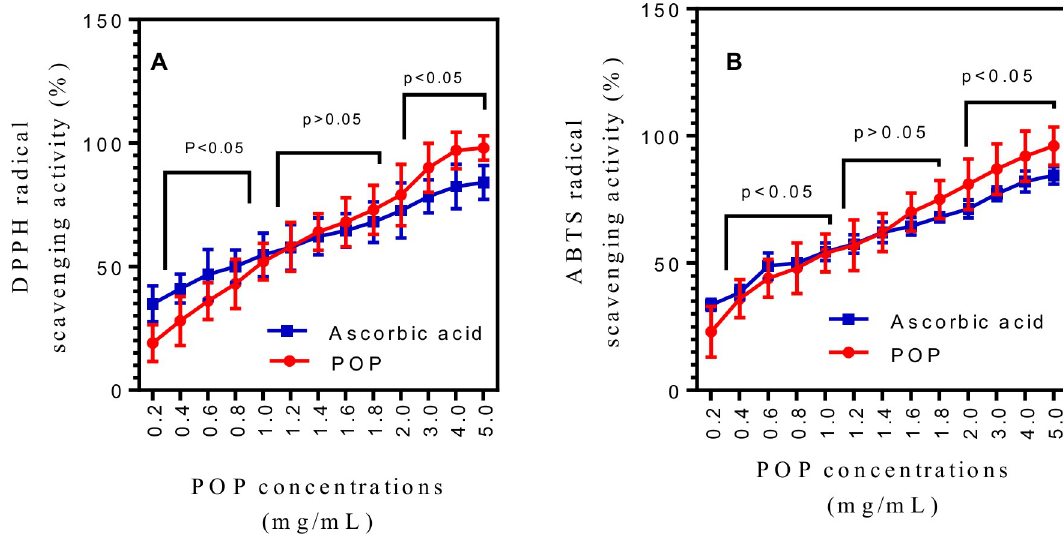
Fig 7. Antioxidant activities of the POP. (A) DPPH radical scavenging activity (p < 0.001, EC 50 = 1038.38 μ g/mL, R 2 = 0.8313) and (B) ABTS radical scavenging activity (p < 0.001, EC 50 = 824.37 μ g/mL, R 2 = 0.8223). POP, Pleurotus ostreatus polysaccharide.